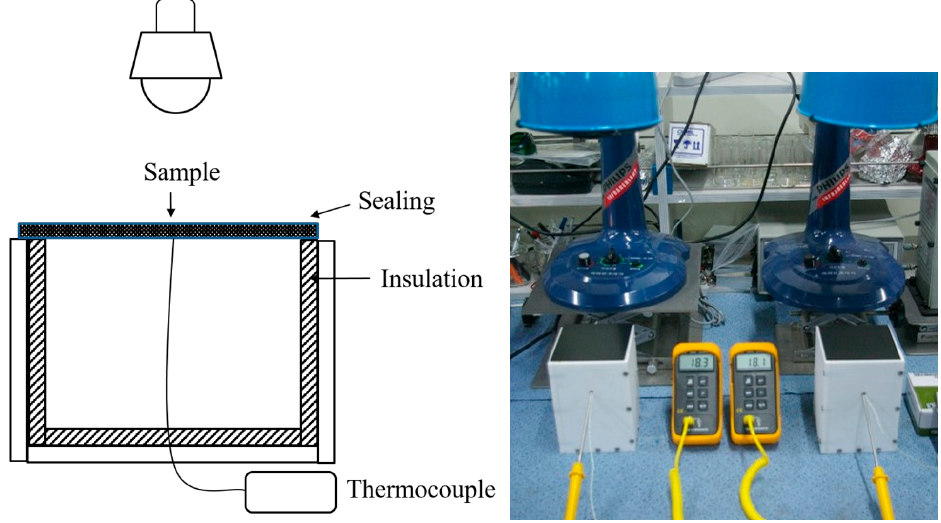
Figure 1. ASTM D4803 modified device for evaluating the IR reflectance of the coated steel sheet.